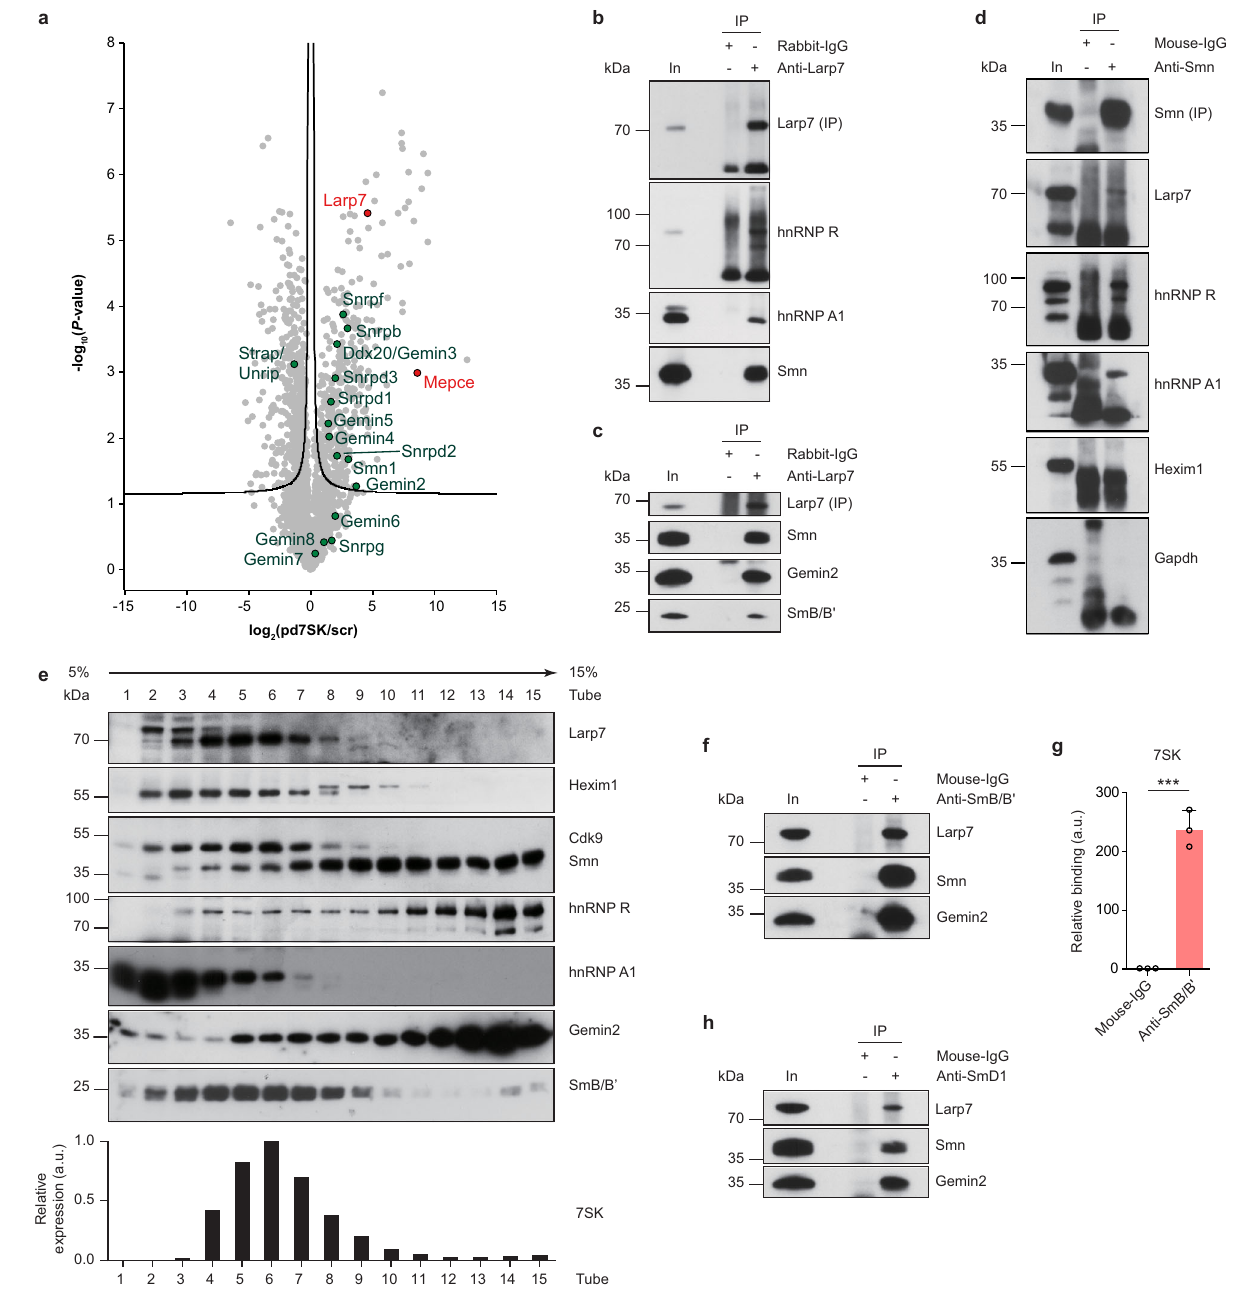
Fig. 1 Smn interacts with 7SK/hnRNP but not with 7SK/P-TEFb complexes. a Volcano plot of the 7SK interaction proteome following pulldown with Biotin-pd7SK and scr control from NSC-34 cell lysate. Smn complex proteins are highlighted in green, the 7SK core interactors Mepce and Larp7 are marked in red. b Western blot analysis of proteins co-immunoprecipitated from NSC-34 cells by an anti-Larp7 antibody directed against the C-terminus of Larp7. Immunoprecipitation with rabbit-IgG antibody was used as control. In, input; IP, immunoprecipitation. c Co-immunoprecipitation of proteins by an anti-Larp7 antibody directed against the N-terminal half of Larp7. d Co-immunoprecipitation of proteins by anti-Smn from NSC-34 cells. Lack of Gapdh co- precipitation serves as speci fi city control. e Sucrose gradient fractionation of NSC-34 cell lysate. Individual fractions were probed by Western blotting for proteins indicated on the right. Lower panel: Detection of 7SK in each fraction by qPCR. a.u., arbitrary units. f Co-immunoprecipitation of proteins by anti- SmB/B ’ from NSC-34 cells. g qPCR analysis of 7SK co-precipitated by anti-SmB/B ’ from NSC-34 cells. Data are mean ± standard deviation (s.d.); *** P ≤ 0.001; unpaired two-tailed t -test ( n = 3). h Co-immunoprecipitation of proteins by anti-SmD1 from NSC-34 cells. Source data are provided as a Source Data fi le. 7SK pulldown data (Supplementary Fig. 1d). These RNA-binding Supplementary Data 3). Among these proteins were Smn, Gemins, proteins were previously identi fi ed as components of 7SK/hnRNP and Sm proteins (Fig. 1a). This fi nding suggests that 7SK/hnRNP particles 24 . Gene ontology (GO) term enrichment analysis particles interact with the Smn complex (Supplementary Fig. 1f). revealed that components of the Smn complex were enriched in To further investigate this interaction, we immunoprecipitated the Biotin-pd7SK co-precipitate (Supplementary Fig. 1e and Larp7, an essential component of 7SK particles 13 , from NSC-34 NATURE COMMUNICATIONS| (2021) 12:1278